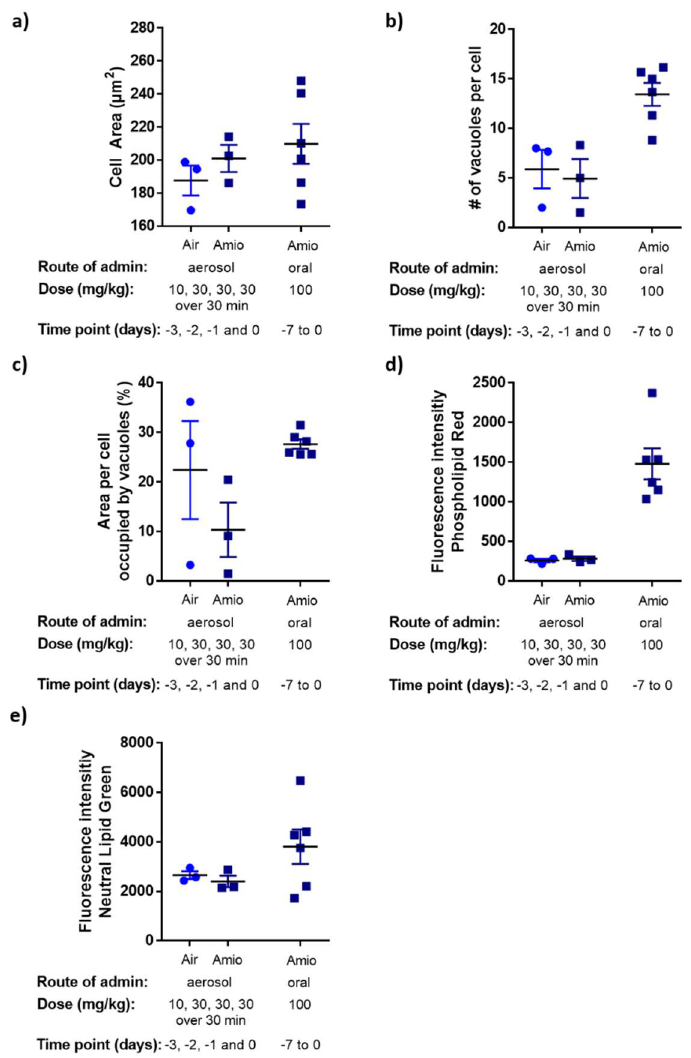
Figure 3. Median cell area ( a ), number of vacuoles per cell ( b ), percentage of cell area occupied by vacuoles ( c ), intensity of phospholipid stain ( d ) and neutral lipid stain ( e ) are reported for macrophages isolated from BAL on day 1 post-dosing. Each data point represents the mean ± standard error of the mean (SEM) of triplicate samples per rat ( n = 3–6 animals). Data from day 7 of the aerosol studies did not show any elevation compared to controls and is reported in the supplementary material section (Figure S1).